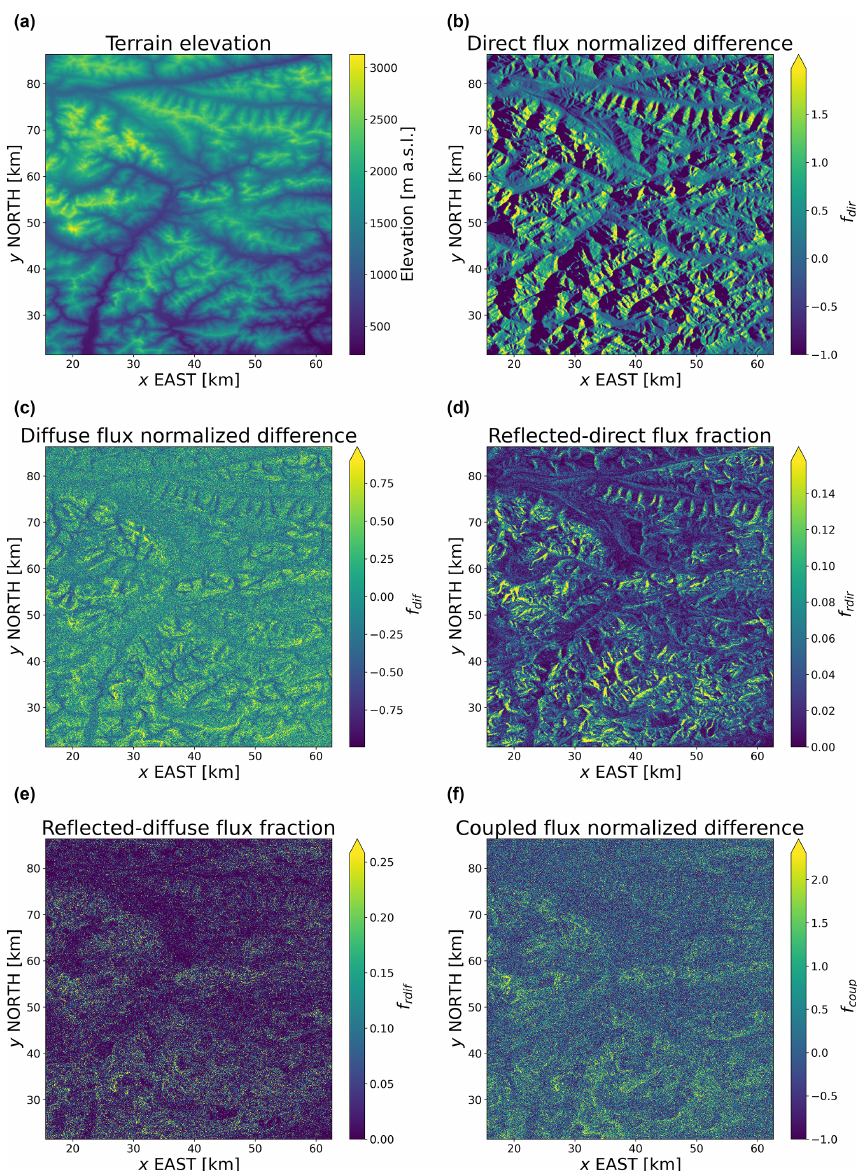
Figure 4. Normalized differences in downward fluxes obtained running Monte Carlo simulations using the real topography and a flat domain, respectively ( µ 0 = 0 . 40, φ 0 = π/ 2). Maps are shown using an equal-area Mollweide